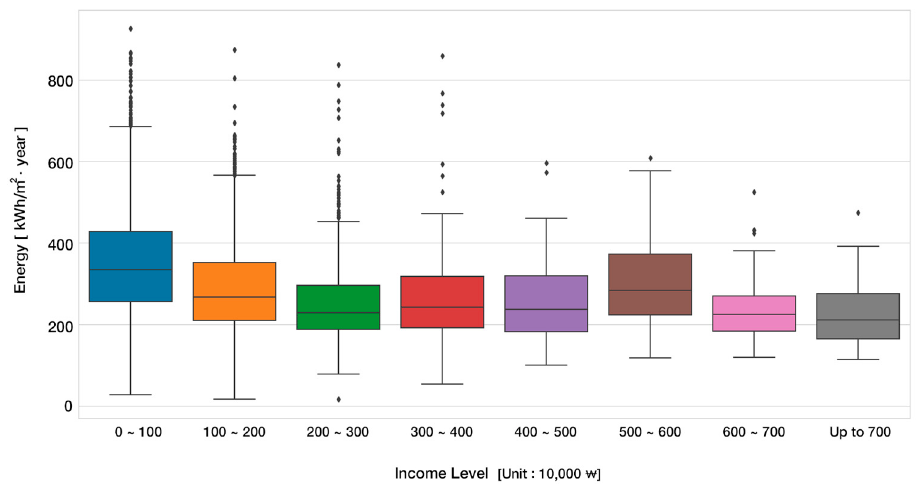
Figure 11. Comparison of energy consumption as a function of income